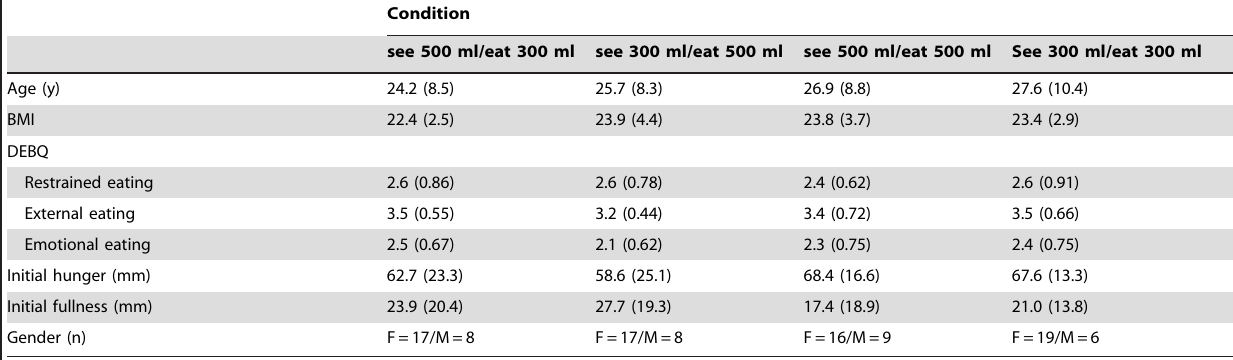
Table 1. Baseline and participant characteristics.